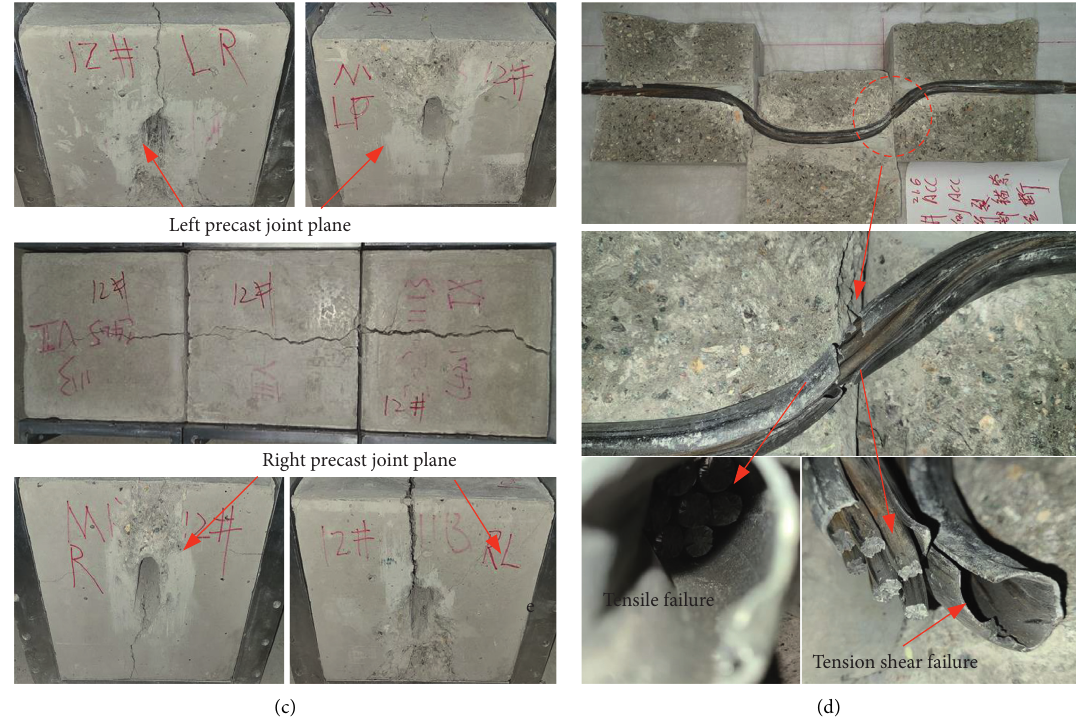
Figure 5: Display of material failure forms. (a) Failure diagram of anchor cables with the diameter of 21.6 mm test block. (b) Schematic diagram of breaking of anchor cables with the diameter of 21.6mm. (c) Failure diagram of ACC with the diameter of 21.6mm test block. (d) Fracture diagram of ACC with the diameter of